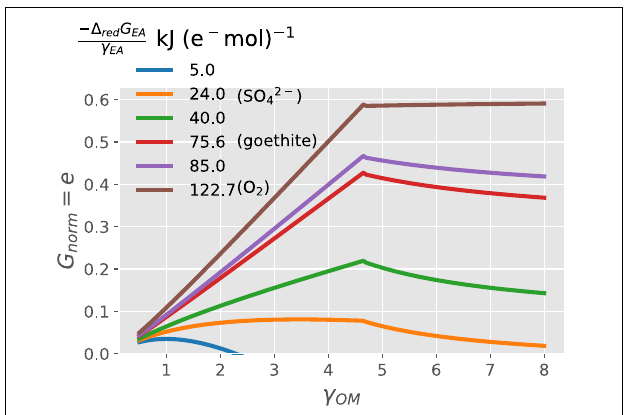
FIGURE 3 | Variation of normalized growth rate ( G norm ) with the degree of reduction of the OM ( γ OM on the x -axis) and energy available from the reduction of EA ( (cid:49) red G EA ; curves with different